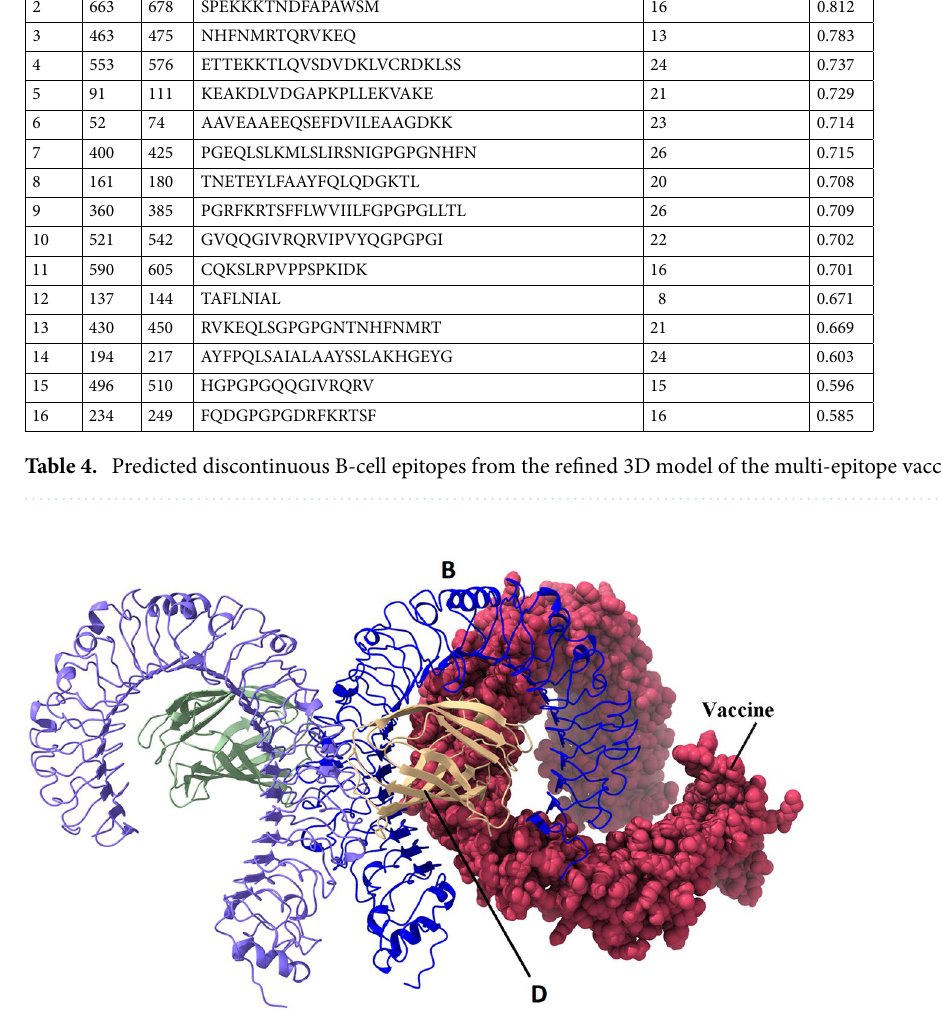
Figure 4. The docked complex of the multi-epitope vaccine and TLR4 was visualized using the UCSF Chimera 1.15rc software. The vaccine construct is shown in the spheres form, while TLR4 is shown in the cartoon